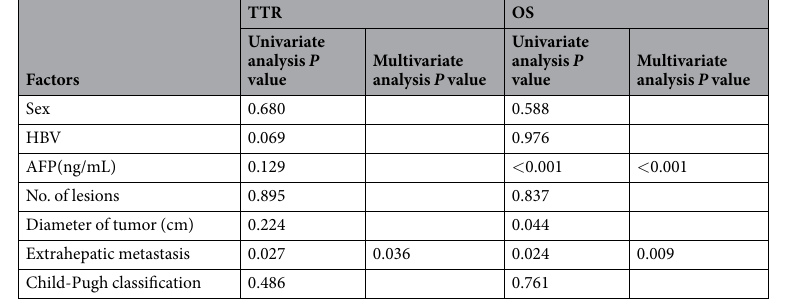
Table 3. Patient characteristics as determinants of TTR and OS.